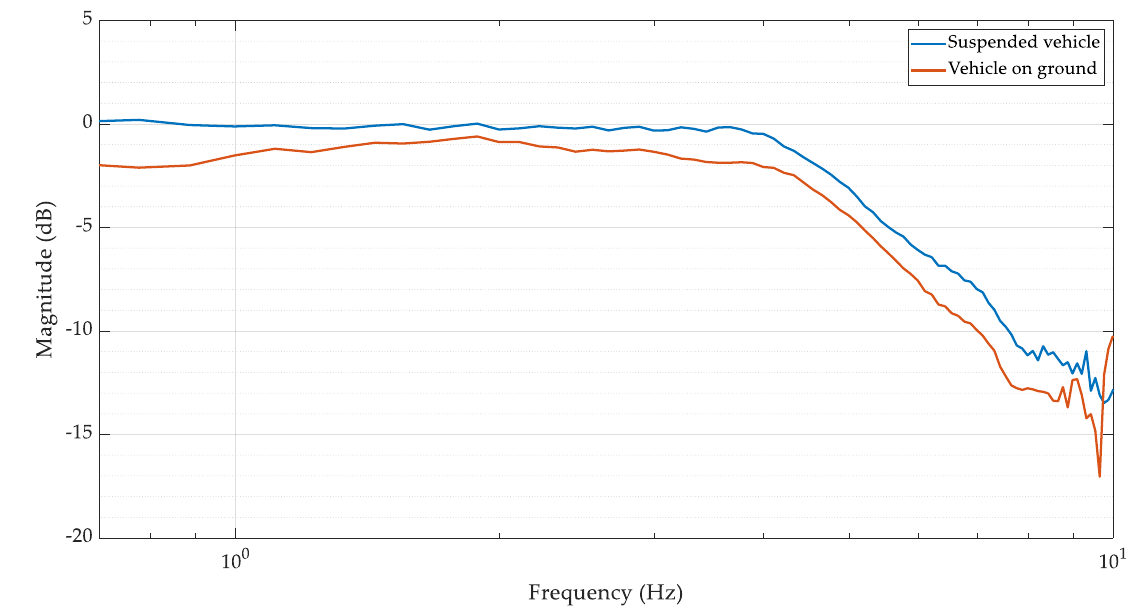
Figure 8. Experimental frequency response function of the closed loop system: suspended vehicle (blue) and vehicle on the ground (orange).